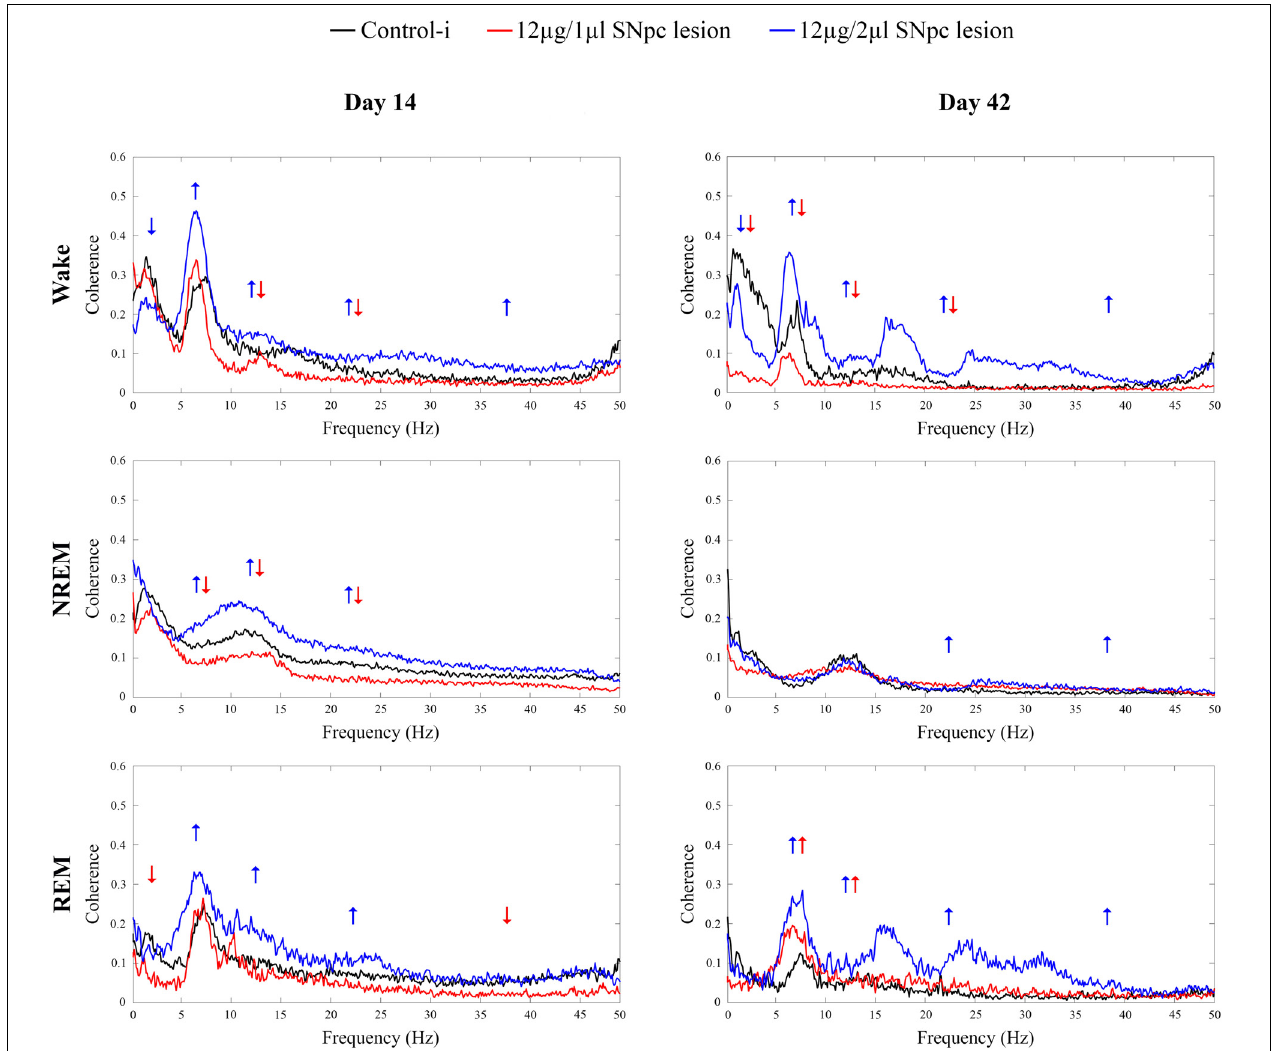
FIGURE 6 | Coherence spectra of all the conventional EEG frequency oscillations between the MCx and hippocampus (Hipp) during Wake, NREM and REM sleep 14 and 42 days following the unilateral SNpc lesions with two distinct microinfusions of 6-OHDA. Arrows indicate the statistically significant mean coherence values at p ≤ 0.05, obtained using the Mann–Whitney U tests, while their directions indicate the increased or decreased coherences following the unilateral SNpc lesions vs. controls.